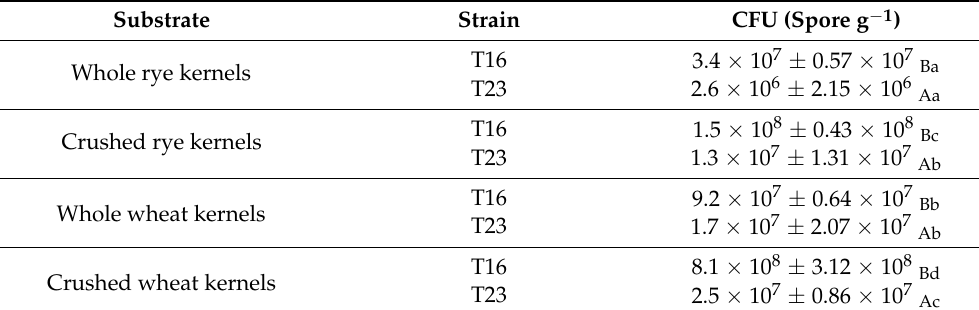
Table 2. Propagule counts of Trichoderma strains T16 and T23 produced on different substrates in semi solid-state